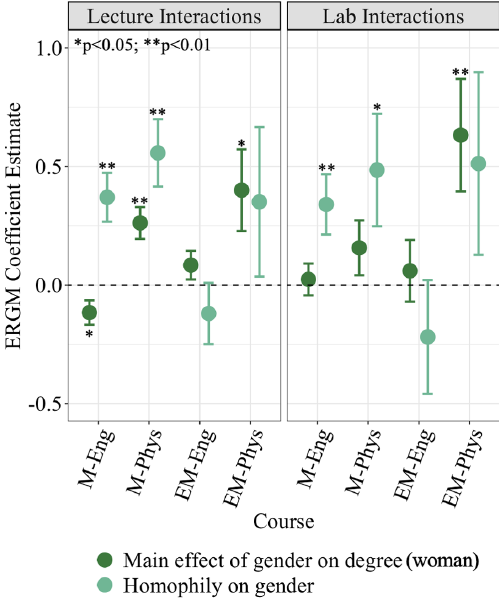
FIG. 7. Plot of ERGM coefficients for the two predictor variables related to race or ethnicity. A more positive (negative) coefficient estimate for the main effect of race or ethnicity on degree variable indicates that URM students have more (fewer) connections than non-URM students. A more positive (negative) coefficient estimate for the homophily on race or ethnicity variable indicates that more (fewer) edges occur between students of the same race or ethnicity. Error bars indicate the standard error for each estimate and asterisks indicate statistical